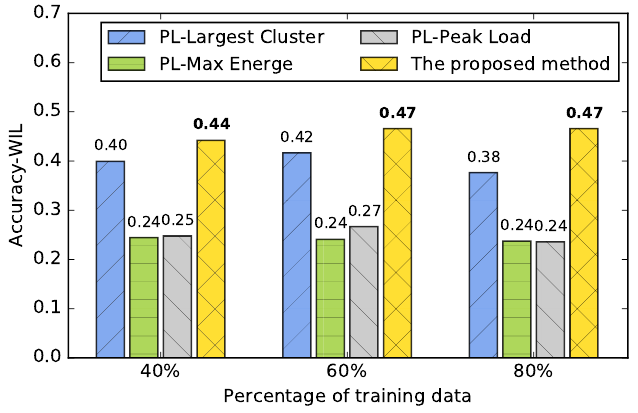
Figure 8. Accuracy with weight of information loss (Accuracy-WIL) of comparison methods in three situations, which are with 40%, 60% and 80% training